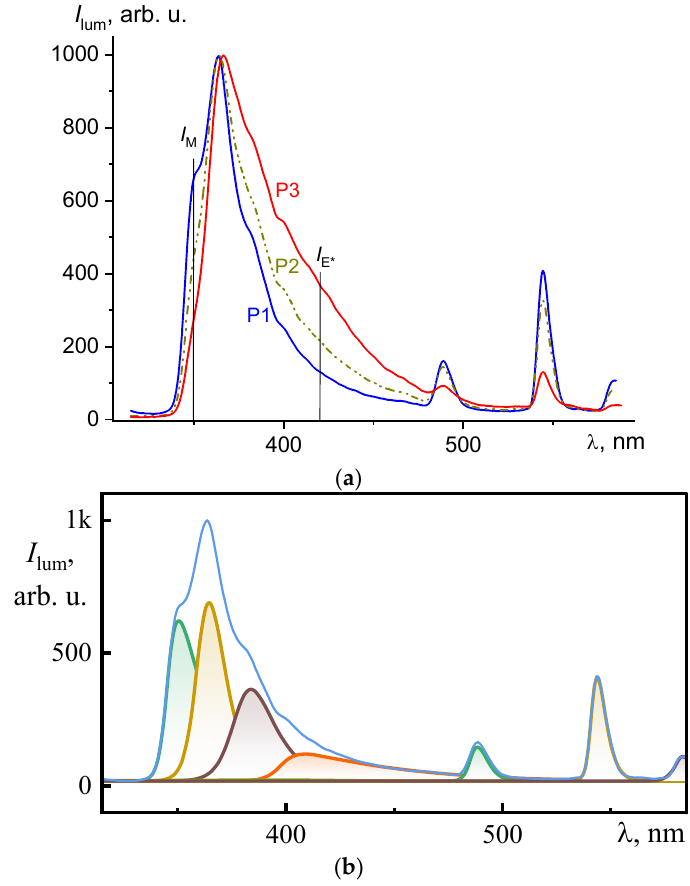
Figure 6. Normalized photoluminescence spectra ( a ) of MPC based on Tb 3+ ions and poly(VT- co - VK) copolymers with 9 (P1), 16 (P2), and 37 mol. % (P3) of VK units in a photoinert PMMA matrix. Excitation 300 nm. Emission spectra are normalized at ca. 365 nm. Deconvolution ( b ) of the normal- ized luminescence spectrum of MPC based on Tb 3+ ions and P1. The squares are raw data from the original spectrum. The red curve is cumulative as the sum of the individual pale-painted peaks ob- tained by deconvolution using Equation (2). The calculation is performed in OriginPro [34].